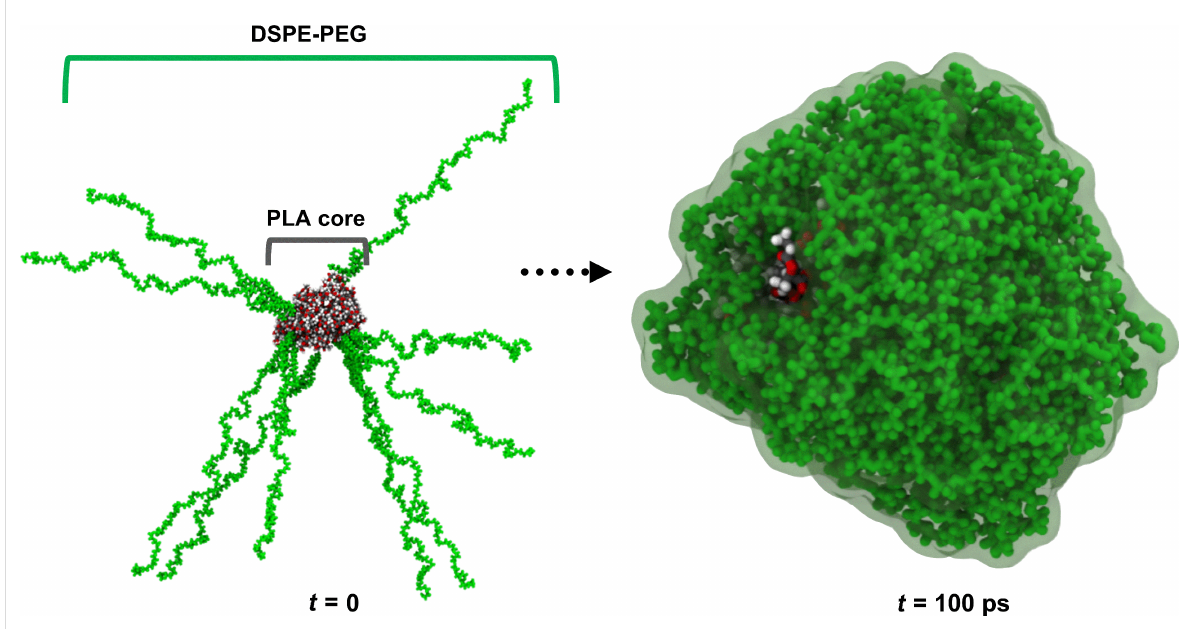
Figure 5: Snapshots of initial (left) and final (right) conformation of PLA–DSPE–PEG-coated structure after 100 ps of simulation. The PLA core is represented with conventional color coding (carbon–gray; hydrogen–white; oxygen–red) and the DSPE–PEG chains are coloured green. Lipid chains fold and cover a significant portion of the PLA core surface.